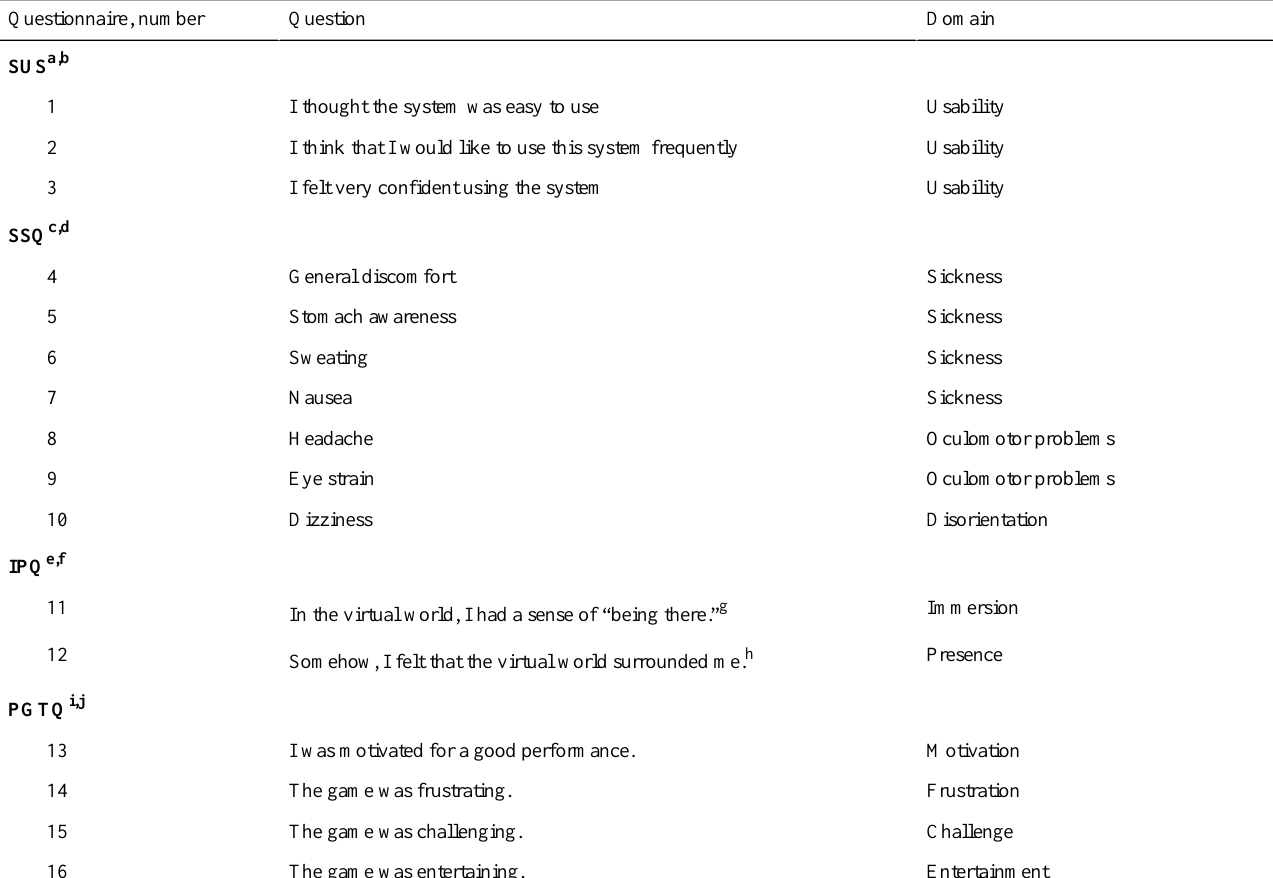
Table 3. Exact formulations that were asked in the